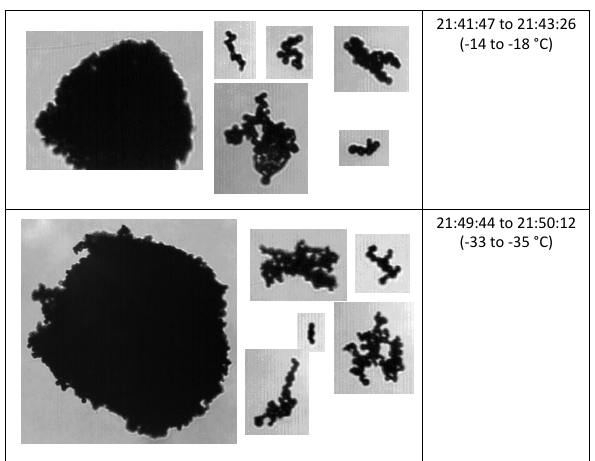
Fig. 15. Examples of FDAs found in warmer regions on 22 June 2012 together with examples of graupel found in the same regions. The graupel image in the lower left is approximately 1.1mm in di- ameter and has been reduced in size by a third, relative to the other images, to fit in the